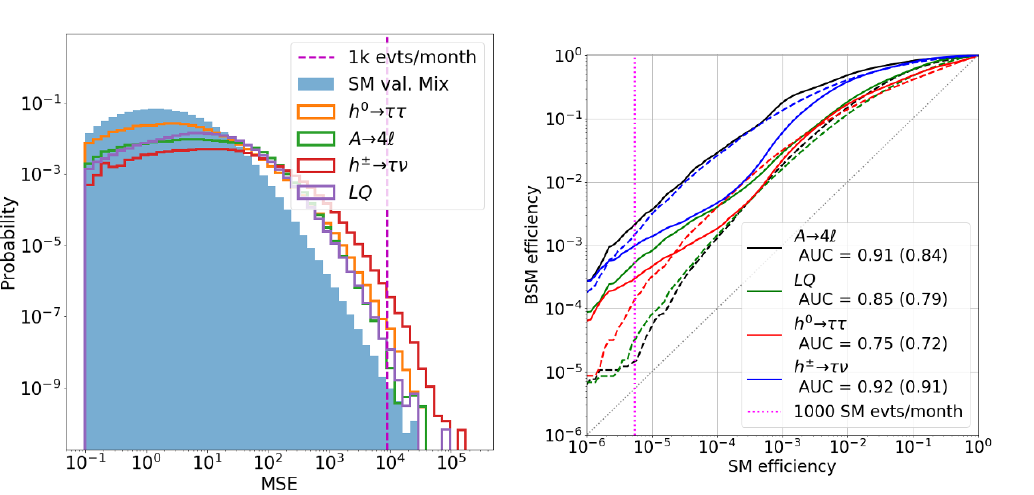
Figure 12 . Left: distribution of the AE loss (MSE) for the validation dataset. The distribution for the SM processes and the four benchmark BSM models are shown. Right: ROC curves for the AE (dashed lines) trained only on SM mix, compared to the corresponding VAE curves from (cid:12)gure 10 (solid). The vertical dotted line represents the (cid:15) SM = 5 : 4 (cid:1) 10 (cid:0) 6 threshold considered in this